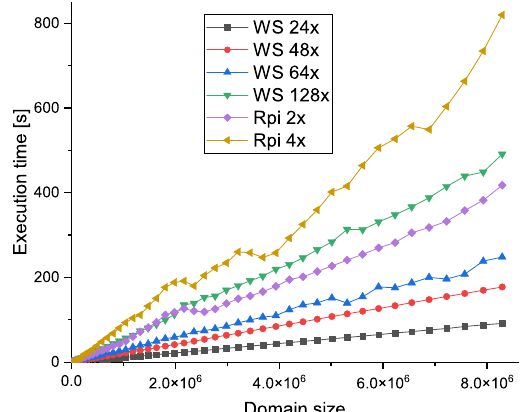
Figure 5. Cellular automaton computing time depending on domain size and device